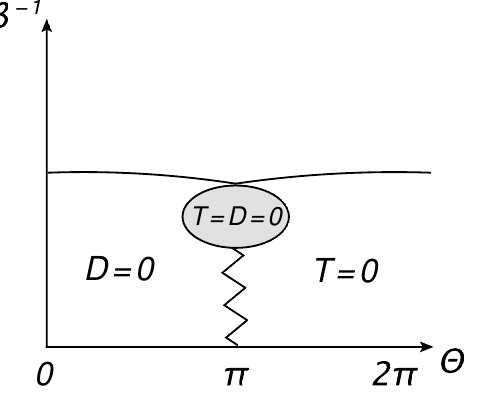
Figure 7 . A suggested phase diagram with an unbroken D 8 phase in the shaded region. In terms of the SU(2) gauge theory, this is a Higgs